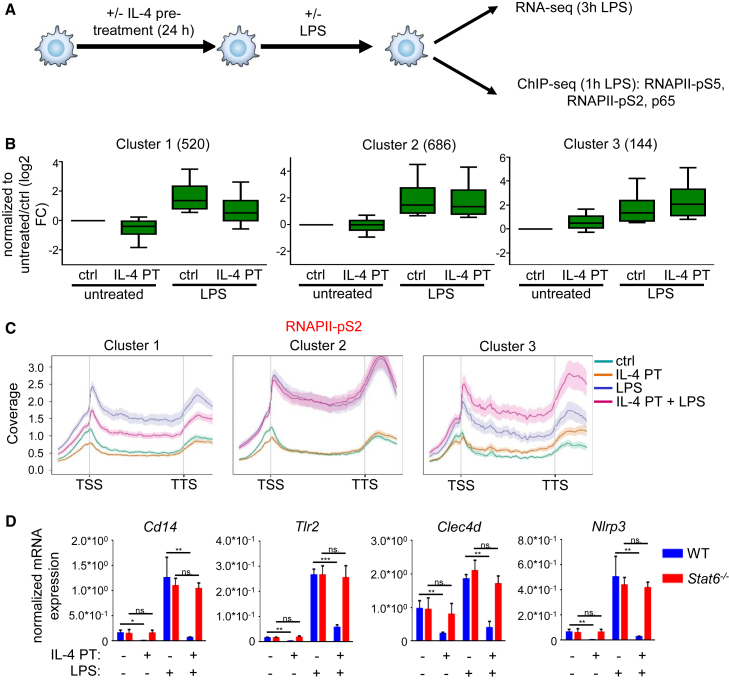
Selective Repression of LPS-Activated Inflammatory Program by IL-4-Activated STAT6(A) Schematic representation of the experimental system.(B) Boxplot of the fold changes of LPS-activated genes (RNA-seq). Clustering was based on the different LPS-induced gene expression effects on IL-4-pretreated and untreated BMDMs (p < 0.05). Data represent the average fold changes of three individual animals from two independent experiments. Boxes encompass the 25th to 75th percentile changes. Whiskers extend to the 10th and 90th percentiles.(C) Metagene plot of RNAPII-pS2 signals over the gene bodies of the genes in the clusters (B). Coverage is defined as read count per million mapped reads. Data are combined from two independent biological replicates.(D) RT-qPCR measurements of basal and LPS-induced expression of the inflammation-associated genes in IL-4-pretreated and unstimulated WT and Stat6−/− BMDMs. Data are cumulative of four individual animals per genotype from two independent experiments. ∗p < 0.05, ∗∗p < 0.01, ∗∗∗p < 0.001, ns, no significant difference. Error bars represent means ± SD.BMDMs were pretreated with IL-4 for 24 hr followed by LPS exposure for 3 hr (B and D) or 1 hr (C).